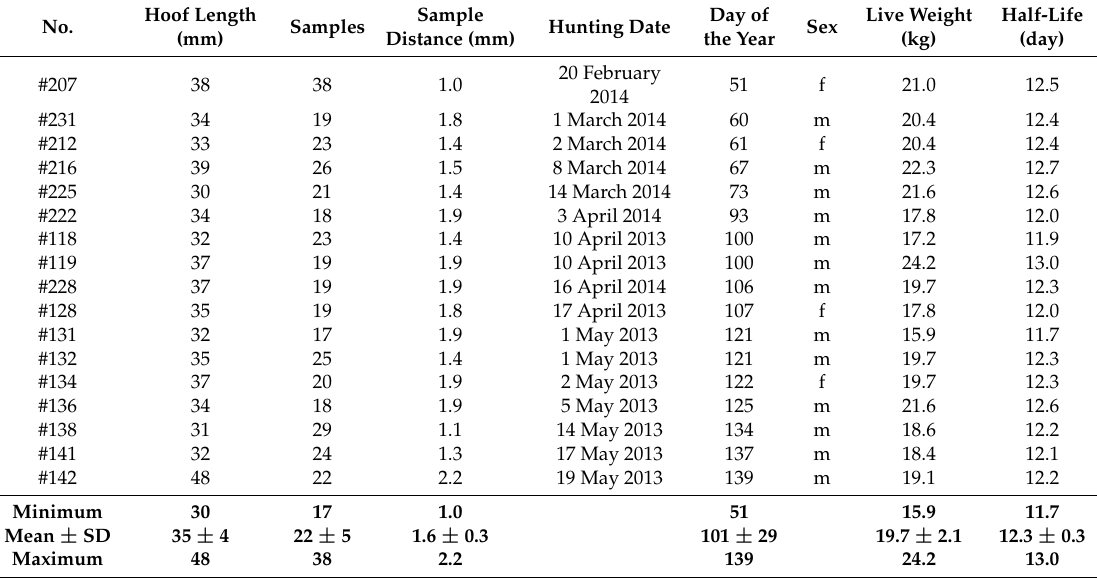
Table 1. Data obtained from 17 roe deer that were hunted between April 2013 and April